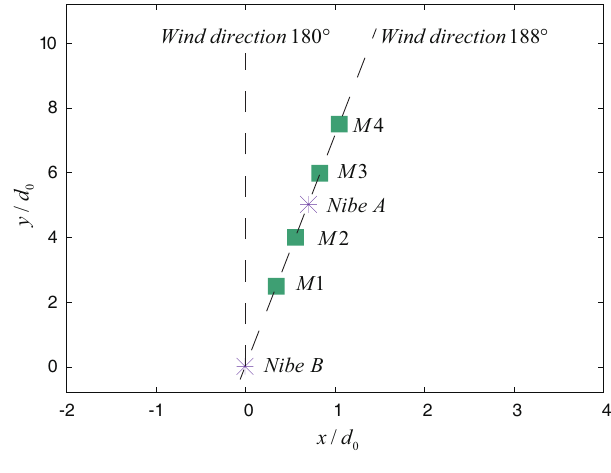
Figure 6. Sketch of the Nibe site.